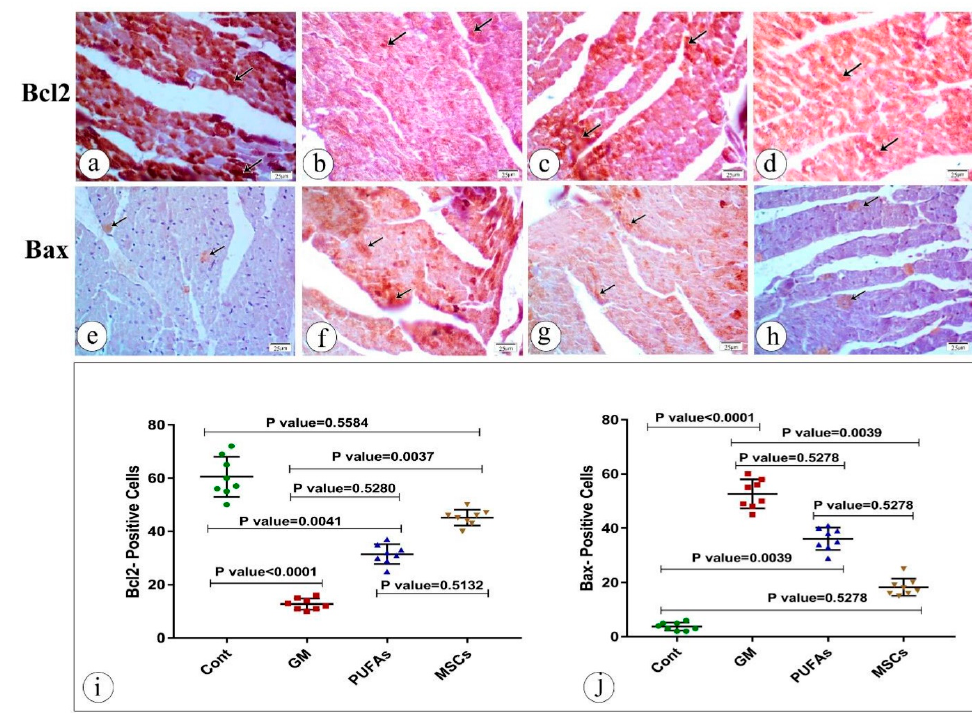
Figure 8. Immunostained sections of heart tissue of Bcl2 and Bax expression in cardiac myocytes in all studied groups. Positive staining is shown by a brown or red color: ( a ) control group showing strong Bcl2 immunohistochemical staining of control heart tissue in most of cardiomyocytes (arrow); ( b ) gentamycin-treated group showing minor positive Bcl2 immunoreactivity in cardiomyocytes (arrow); ( c ) gentamycin- and PUFA-treated group showing moderately positive Bcl2 immunoreactivity in some of the cardiomyocytes (arrow); ( d ) gentamycin- and MSC-treated group showing strong positive Bcl2 immunoreactivity in most cardiomyocytes (arrow); ( e ) control group showing positive Bax immuno- histochemical staining of control heart tissue in a few myocytes (arrow); ( f ) gentamycin-treated group showing strong positive Bax immunoreactivity (overexpression of Bax) in the cardiomyocytes (arrow); ( g ) gentamycin- and PUFA-treated group showing moderately positive Bax immunoreactivity in some of the cardiomyocytes (arrow); ( h ) gentamycin- and MSC-treated group showing slight dark-red positive Bax immunoreactivity in most myocytes almost similar to the control (arrow). ( i , j ) respectively showing Statistical analysis of Bcl2 and Bax expression in cardiac myocytes in all groups studied. Nonparametric statistics were used. Data were analyzed using the Kruskal–Wallis test followed by Dunn’s test. Results are expressed as medians and interquartile ranges. Differences were considered significant at p <